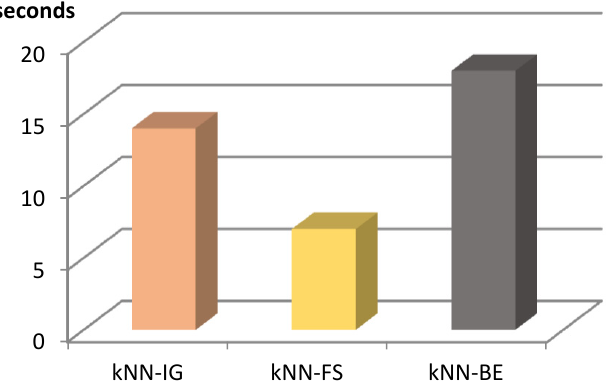
Figure 14. Level of execution time.